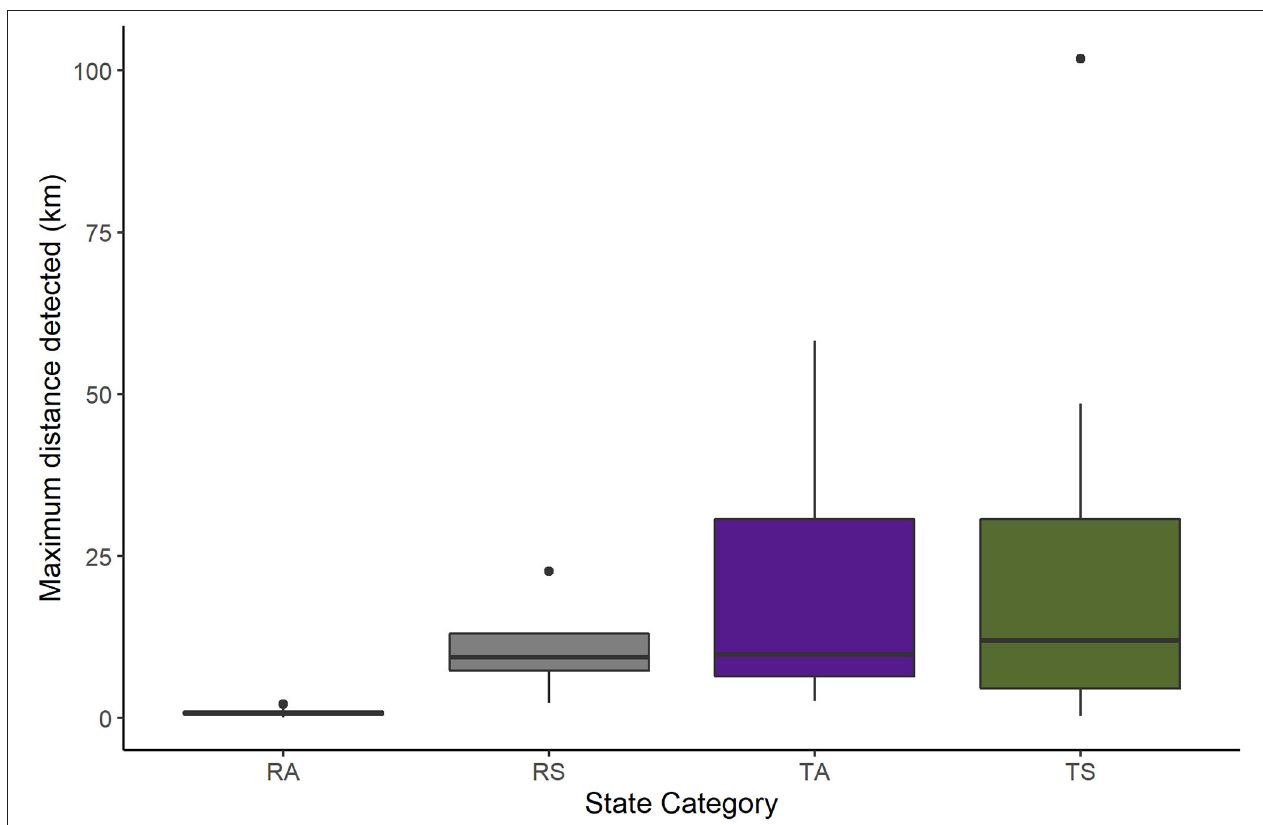
FIGURE 1 | The maximum distance between the most upstream and downstream locations resident adult (RA, n = 9), resident subadult (RS, n = 4), translocated adult (TA, n = 21), and translocated subadult (TS, n = 19) beavers were detected (km) in the Price, San Rafael, and Green Rivers in east-central Utah, USA. Beavers were monitored via PIT-, VHF-, and GPS-tags from May 2019 to March 2020. The boxes encompass the first through third quartiles (25–75 percentiles), while the whiskers extend to the highest or lowest values within 1.5 times the inter-quartile range (the distance between the first and third quartiles). Maximum distances detected outside of this range are outliers and plotted as